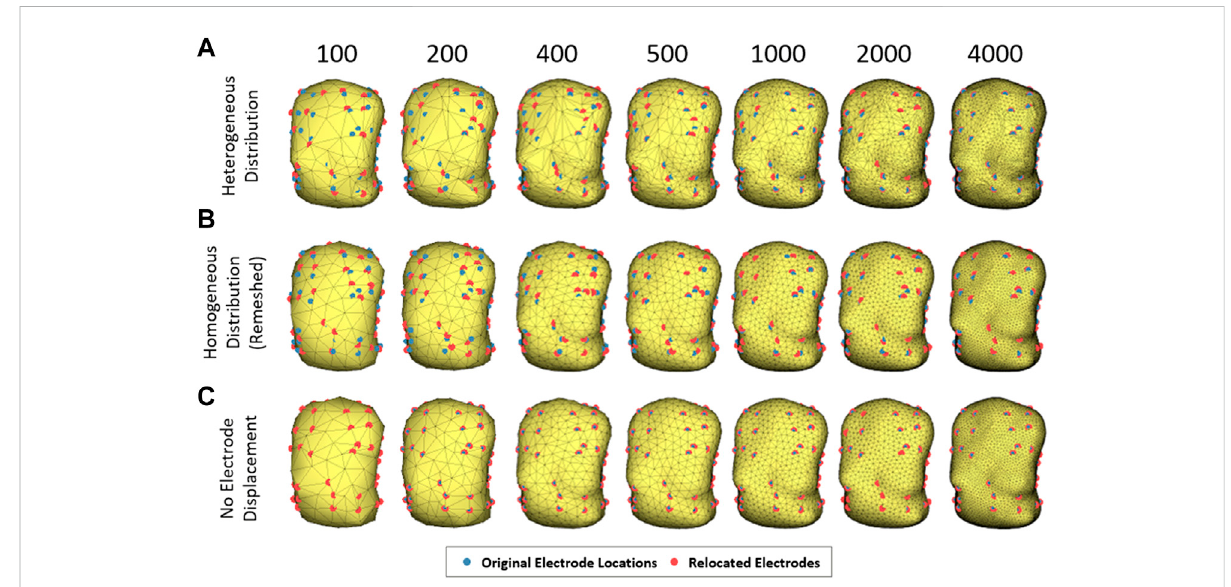
FIGURE 1 Example of torso models with different number of nodes and node distribution. The electrodes relocated appear in blue and the original locations inred. (A) illustratestorsoswithirregularmeshdistribution, (B) withhomogeneous distributionand (C) torsosmaintainingtheelectrodesin the original